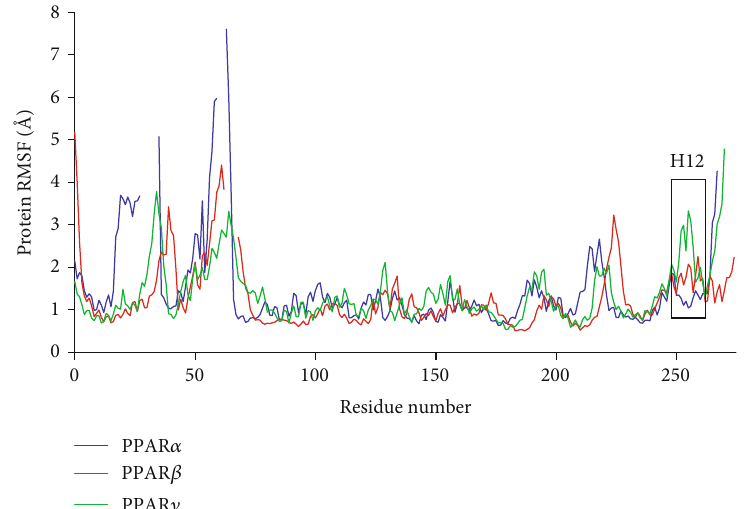
Figure 7: Average receptor protein C α RMSF for all trajectories of PPAR α (red), PPAR β (blue), and PPAR γ (green), presented with the sequences